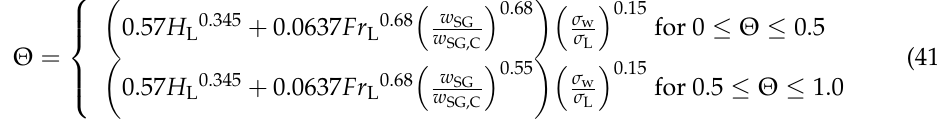
flow is still not well understood. This phenomenon is affected by many factors, such as